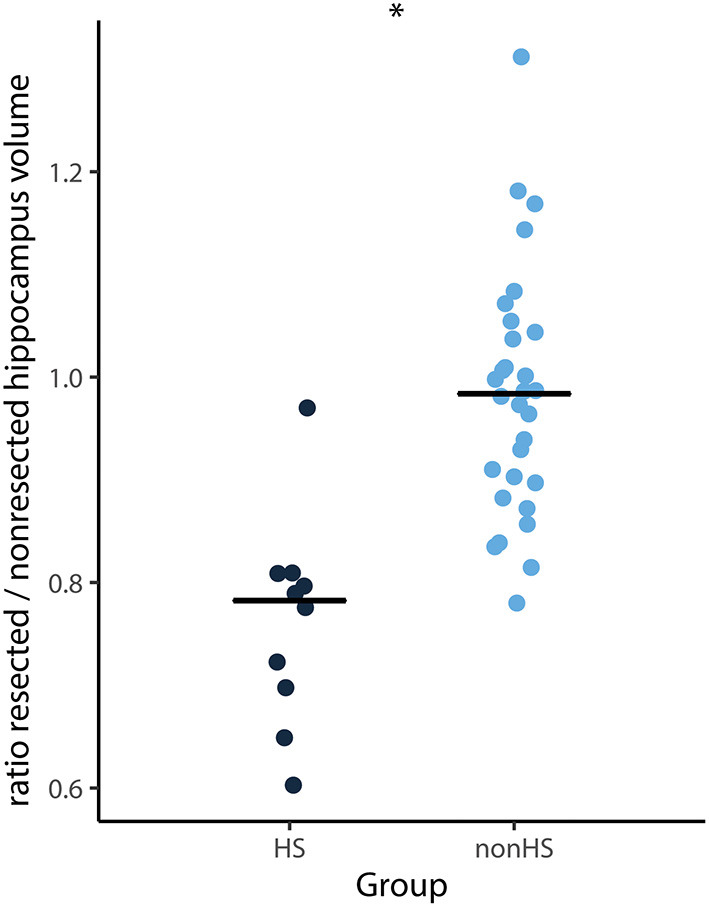
Ratio of total hippocampal volume (surgical side divided by non-surgical side) of each patient and median (horizontal lines) of HS (black) and non-HS (blue) patients. The ratio was significantly smaller for patients with HS compared to non-HS patients (*p < 0.001).